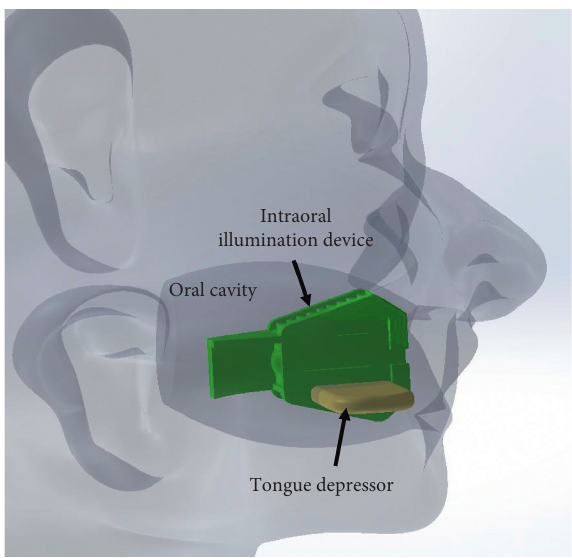
Figure 1: Oral lighting structure design schematic diagram.